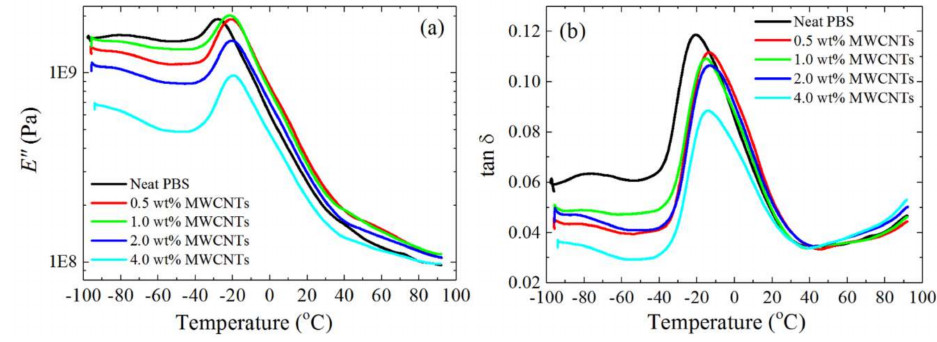
Figure 4. DMA ( a ) loss modulus ( E ”) and ( b ) tan δ curves for the investigated